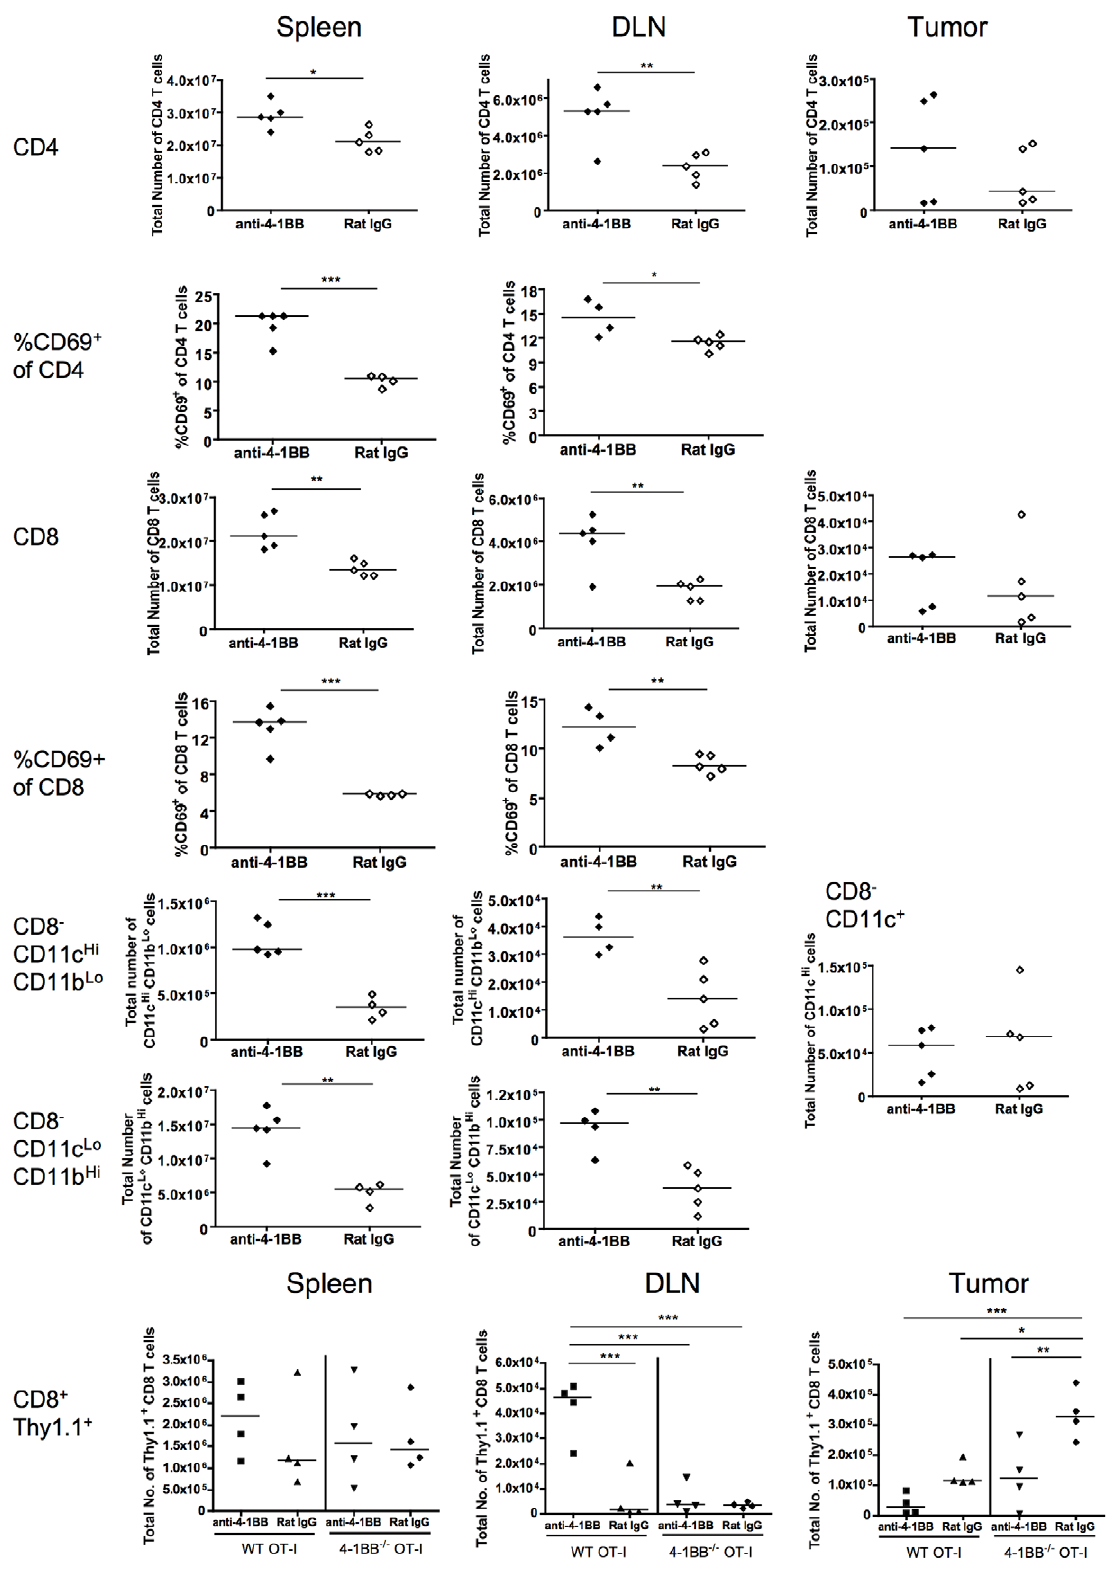
Figure 5. Effect of systemic anti-4-1BB on the frequency and number of immune cells recovered. Mice bearing 8-day E.G7 tumors were treated with reactivated memory OT-I T cells and anti-4-1BB or rat IgG control as in Figure 4A. On day 4, mice were sacrificed and the number of CD4, CD8 T cells, CD11c hi and CD11c int CD8-negative cells (DC and macrophages), as well as transferred T cells were analyzed by flow cytometry. In the bottom panel, recovery of WT reactivated memory OT-I T cells was compared with the 4-1BB 2 / 2 reactivated memory OT-I T cells, indicating that OT-I T cells can only expand in response to anti-4-1BB when they express 4-1BB. Each data point represents an individual mouse. Data are representative